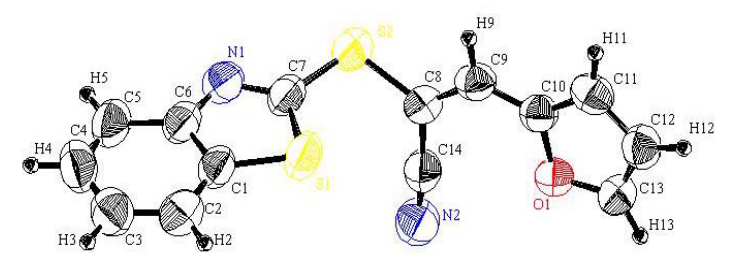
Figure 3. Perspective view and atom labeling of the X-ray structure of 4a .